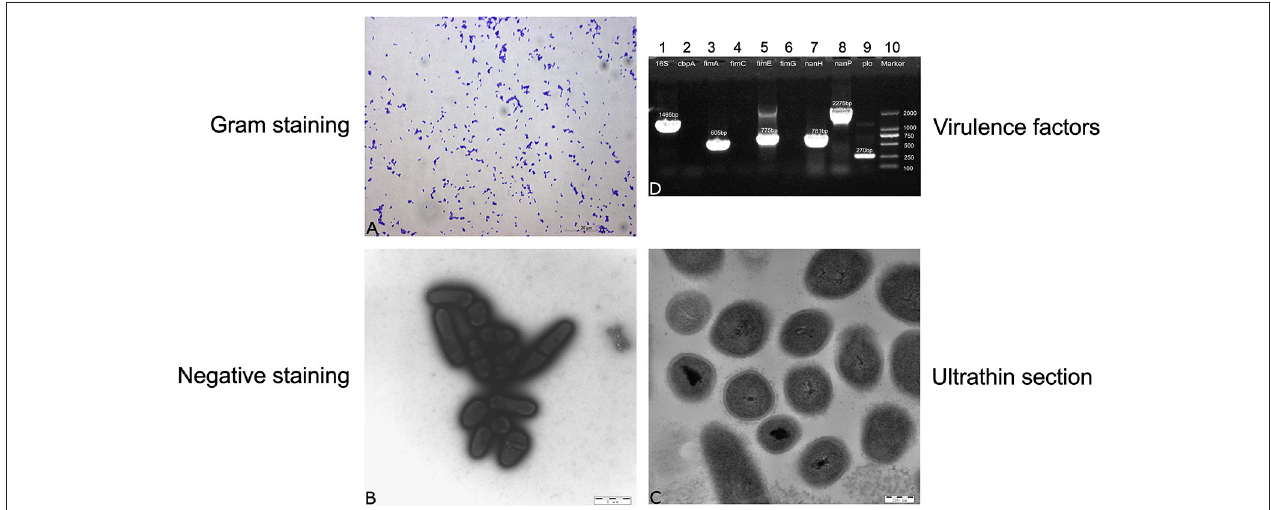
FIGURE 1 | Morphological evaluation and screening of genes encoding virulence factors. (A) Gram staining for strain 20121, (B) negative staining for strain 20121 on transmission electron microscope (C) ultrathin section for strain 20121 on transmission electron microscope, (D) PCR analysis of virulence factors genes, 1: 16S-rRNA , 2: cbpA , 3: fimA , 4: fimC , 5: fimE , 6: fimG , 7: nan-H , 8: nan-P , 9: plo , 10: